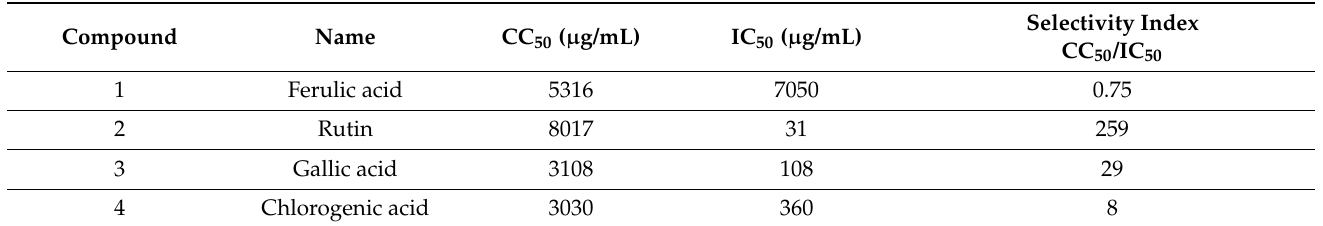
Figure 6. CC 50 and IC 50 . The cytotoxicity values for studied compounds were assessed on Vero E6 cells while their antiviral activities were evaluated against SARS-CoV-2 (hCoV-19/Egypt/NRC-03/2020 (Accession Number on GSAID: EPI_ISL_430820). Table 4. Cytotoxicity and virus-inhibitory effect of the isolated compounds ( 1 – 4 ) against SARS-CoV-2.